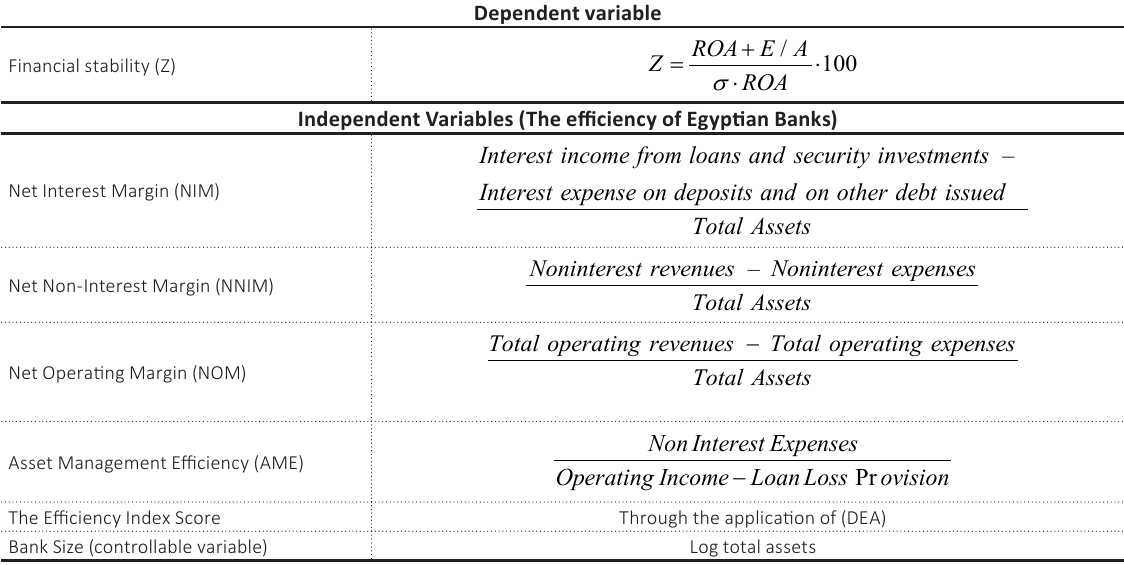
Table 2. Variables’ definitions